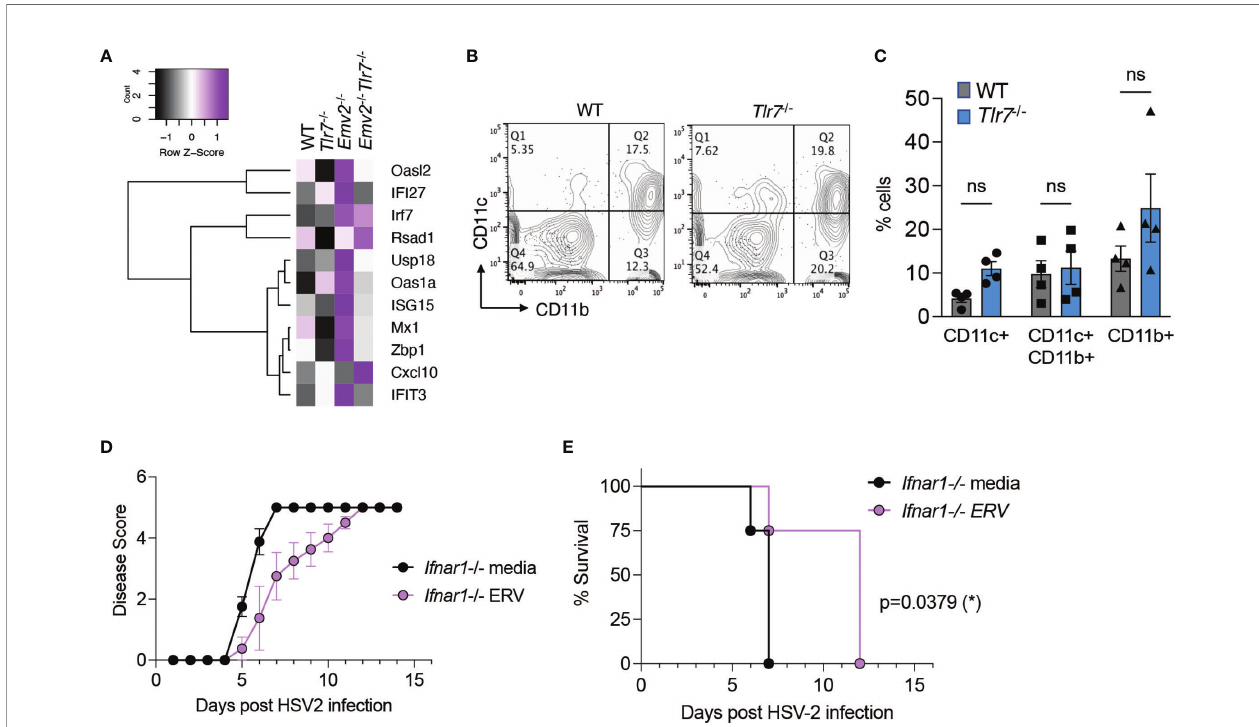
FIGURE 5 | Puri fi ed ERVs from Tlr7 -/- mice confer protection against HSV-2 disease in the absence of IFN- a / b receptor. (A) Heatmap depicting expression levels of IFN-stimulated genes in the indicated vaginal tissues. (B) A representative fl ow cytometry plot depicting CD11b and CD11c staining on vaginal tissues from naïve WT and Tlr7 -/- mice, gated on singlets/live/CD45+ cells. (C) Compiled data for fl ow cytometry analysis of CD11b + and CD11c + cells (n=4 per group). Two-way ANOVA with Sidak ’ s multiple comparisons were performed to calculate statistical signi fi cance. ns, not signi fi cant. (D, E) HSV-2 infection of Ifnar1 -/- mice treated intravaginally with optiMEM (media) or ERVs (n=4 mice per group) and monitored for disease score and survival. Log-rank (Mantel-Cox) test was performed to calculate signi fi cance. *p <